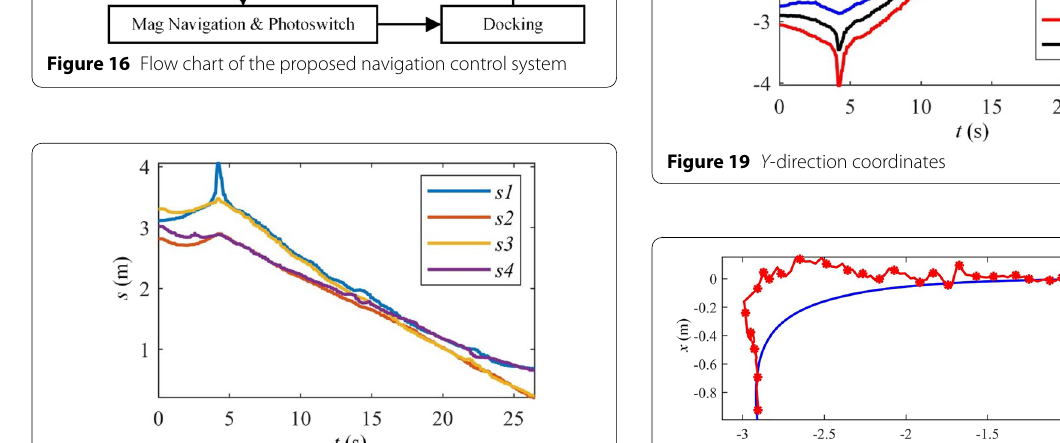
Figure 20 Result of the hybrid navigation control